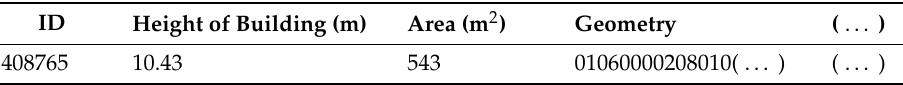
Table 1. Example of a building saved in the PostgreSQL / PostGIS database.